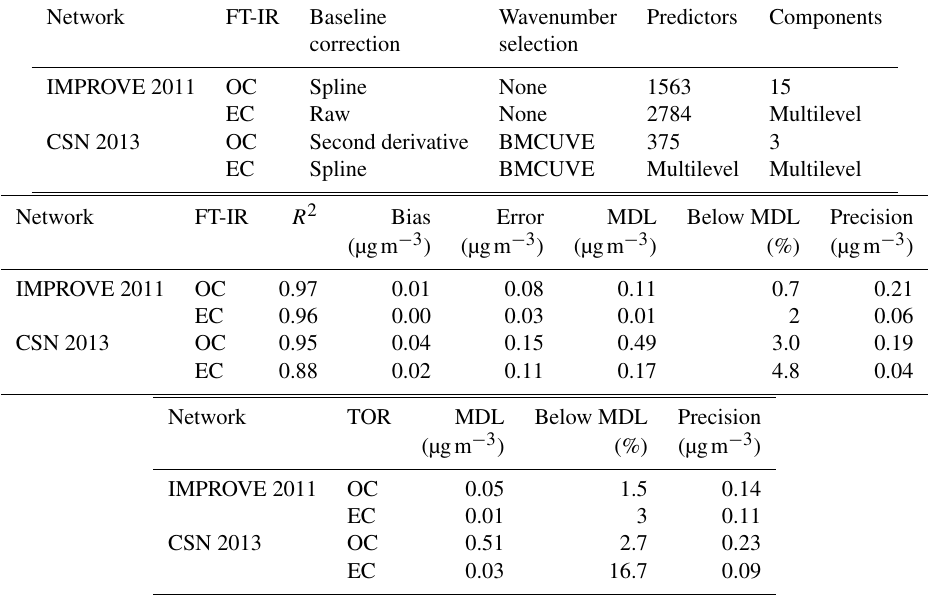
Table 2. Description and figures of merit for “base case” models. “Predictors” describes the number of wavenumbers and “Components” describes the number of LVs. Bias and errors are estimated by ensemble